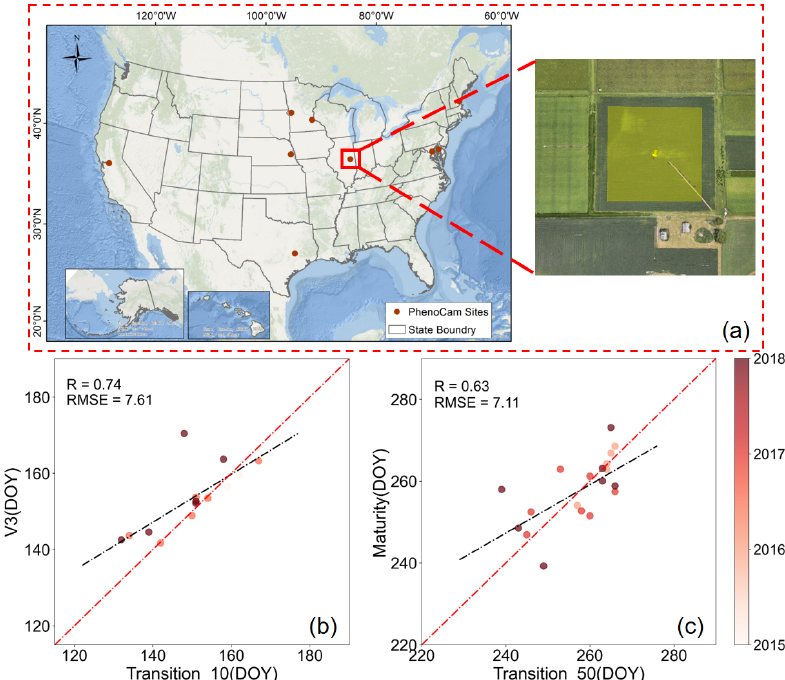
Figure 10. Selected PhenoCam sites in agriculture ecosystems (a) . The annual v3 (b) and maturity (c) dates were compared between the Landsat, and PhenoCam derived results from 2015 to 2018. The base map is provided by ESRI (https://www.arcgis.com/apps/mapviewer/ index.html, last access: 13 August